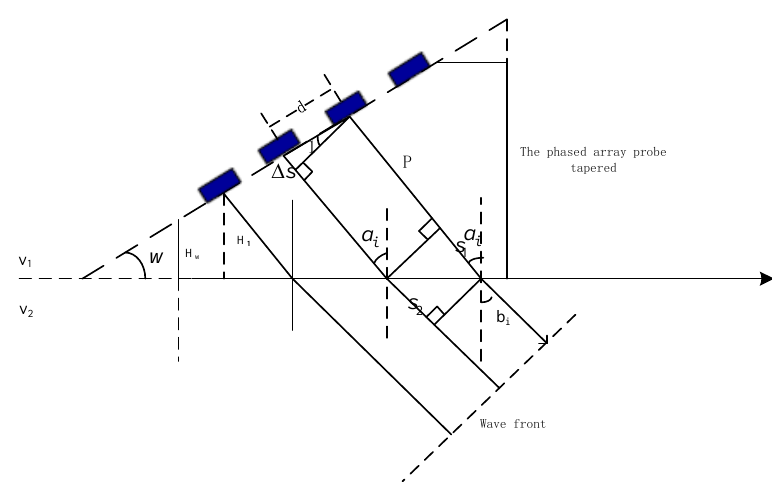
Figure 4. Steering beam from the linear phased-array transducer.